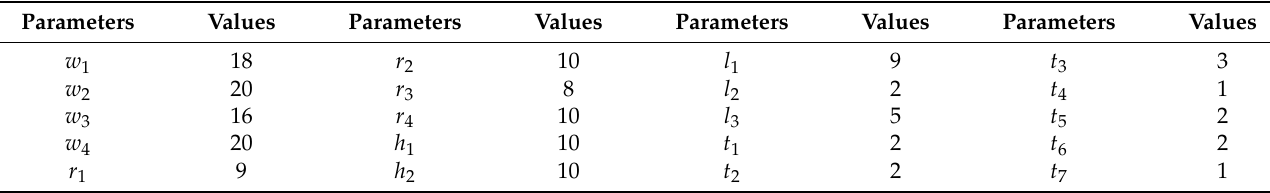
Table 1. Parameters of the proposed SPA (unit: mm).